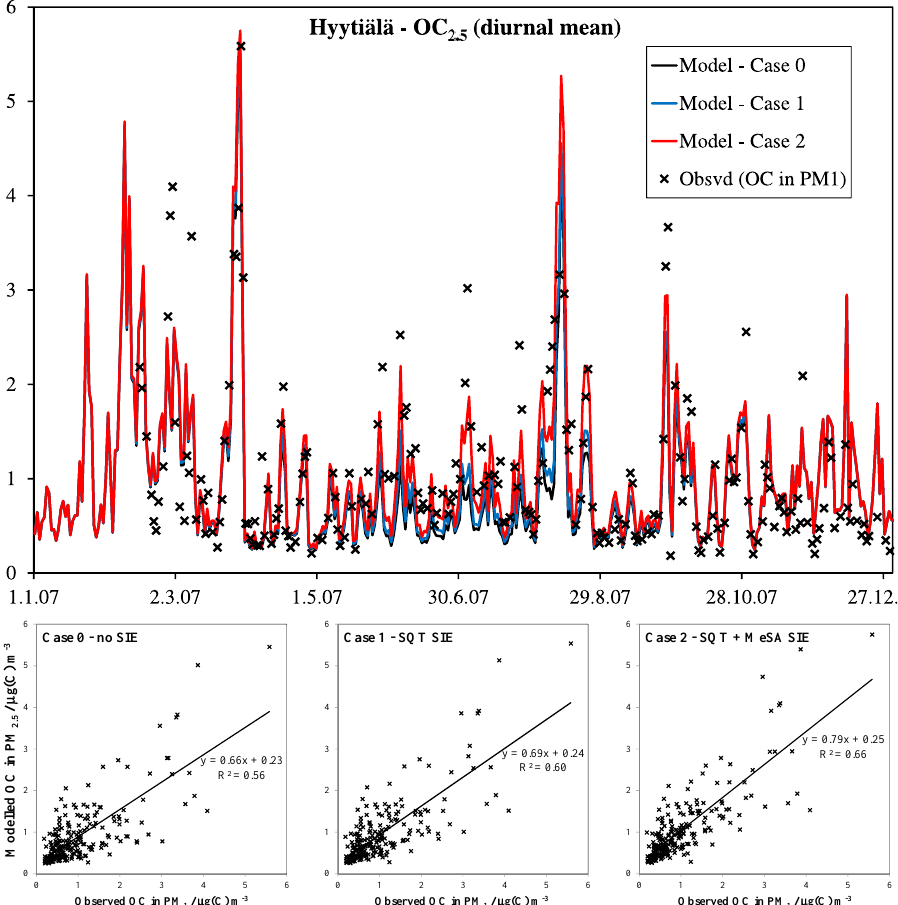
Figure 2. Modelled diurnal mean organic carbon in PM 2 . 5 (OC 2 . 5 ) at Hyytiälä (Finland) for 2007 compared to measured OC in PM 1 (Aurela et al., 2011). Results from three different model simulations (see Sect. 2.5) are shown in the top panel: Case 0 (black line) – reference scenario, without explicit stress-induced emissions (SIE); Case 1 (blue) – current situation scenario with SIE of sesquiterpenes (SQT); Case 2 (red) – current situation scenario with SIE of SQT and methyl salicylate. The lower panels show the model–measurement scatter plots for the three cases. Unit: µg ( C ) m − 3